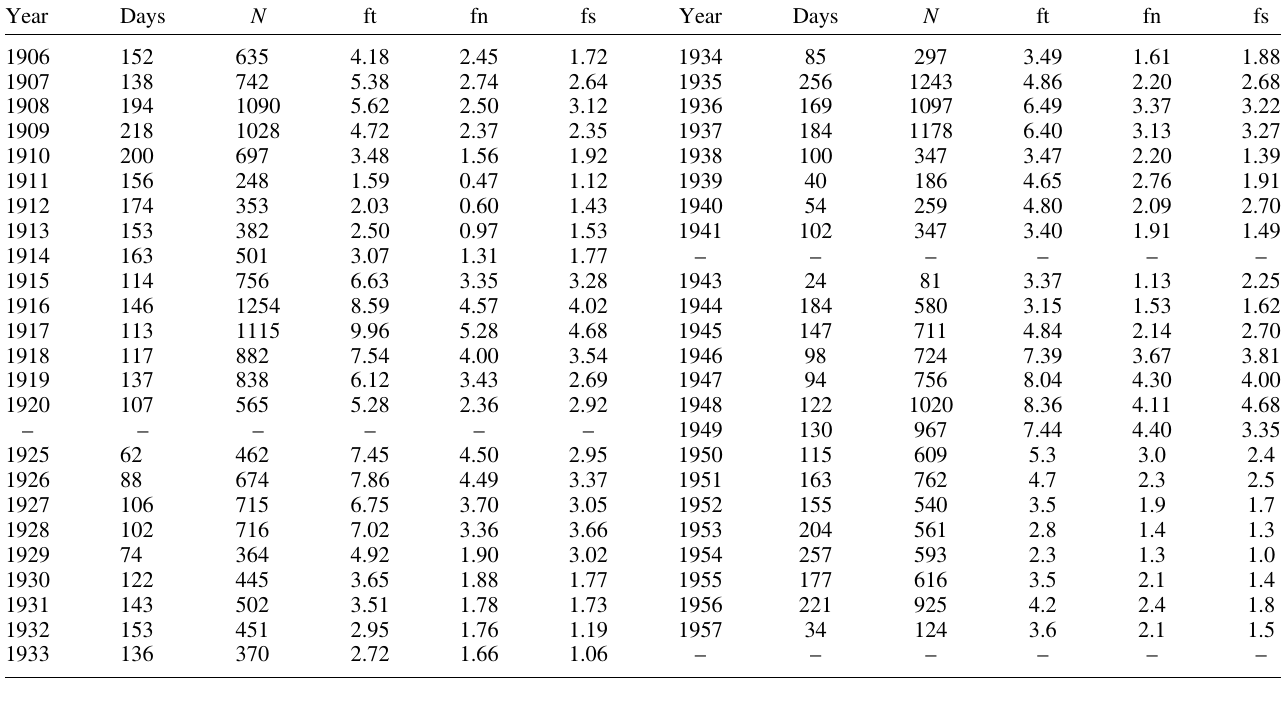
Table 2. Data of the homogenized series of the annual number of prominences with heights of 25 00 and more of the Madrid Astronomical Observatory obtained in this work for the period 1906 – 1957. The columns represent: (i) the year of the observations, (ii) the number of observation days in the corresponding year, (iii) the number of prominences observed in the corresponding year, and frequency of the (iv) total, (v) north, and (vi) south number of prominences (that is, the total, north, and south number of prominences divided by the number of observation days).